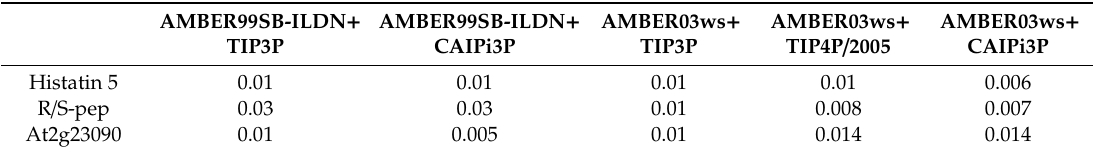
Table 5. Root-mean-square di ff erence between experimental SAXS and calculated SAXS pair distance